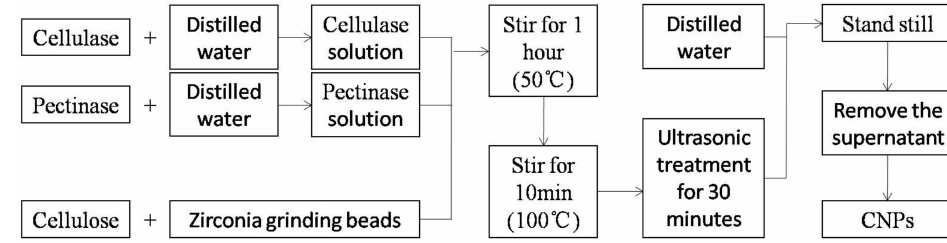
Figure 1. Flow chart of CNPs